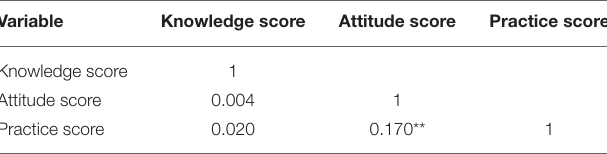
TABLE 4 | Correlations between knowledge, attitude, and practice